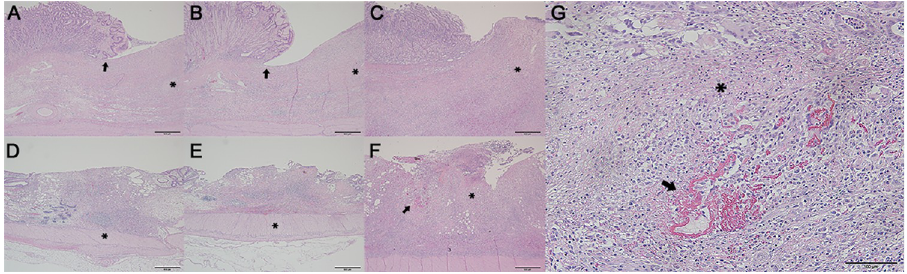
Fig 3. Histologic representation of endoscopic submucosal dissection (ESD) induced ulcer after 7 days. The first and second row indicate gastric and colonic ulcers after ESD, respectively. Administered by (A) normal saline and (B) 0.4% hyaluronic acid revealing a microscopically sharply demarcated ulcer (arrow) without hemorrhage (asterisk), and by (C) chitosan/ β -glycerophosphate, presenting a loss of the mucosal layer with a hypertrophied submucosal layer (asterisk) at the ulcer base. Hematoxylin-Eosin (H & E) stain; x40. The colonic ulcer injected by (D) normal saline, (E) 0.4% hyaluronic acid showing a smooth margin without hemorrhage and perforation (asterisk), and (F) a chitosan/ β - glycerophosphate ulcer presenting with a thickened submucosal layer (asterisk), and focal lysis (arrow) with granulation tissue, H & E; x40, (G) The gastric tissue administered with chitosan/ β -glycerophosphate solution exhibiting focal cell lysis (asterisk) and fibrinolysis (arrow), which is indicative of minimal hemorrhaging (strong pink). H & E; x200.